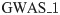
Simulation settings.(A) 20% associated SNPs for each phenotype and 75% extra overlaps between GWAS_1 and GWAS_2 and between GWAS_3 and GWAS_4; (B) 20% associated SNPs and 25% extra overlaps; (C) 20% associated SNPs with varying extra overlaps (25% between GWAS_1 and GWAS_2 and 75% between GWAS_3 and GWAS_4); and (D) Varying proportion of associated SNPs (20% for GWAS_1 and GWAS_2 and 5% for GWAS_3 and GWAS_4) with 75% extra overlaps.